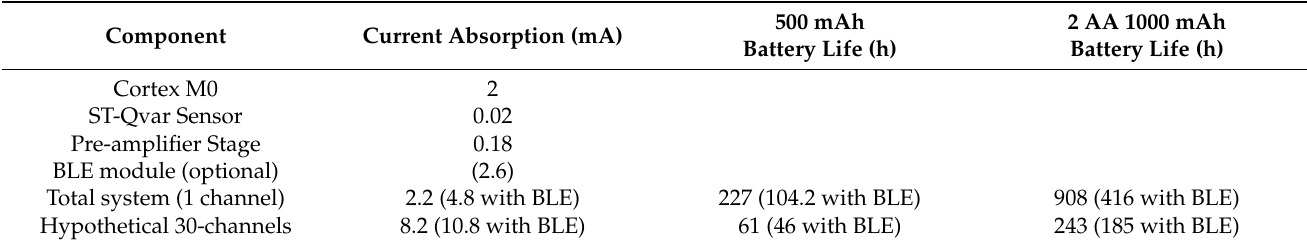
Table 2. ST-Qvar prototype consumption